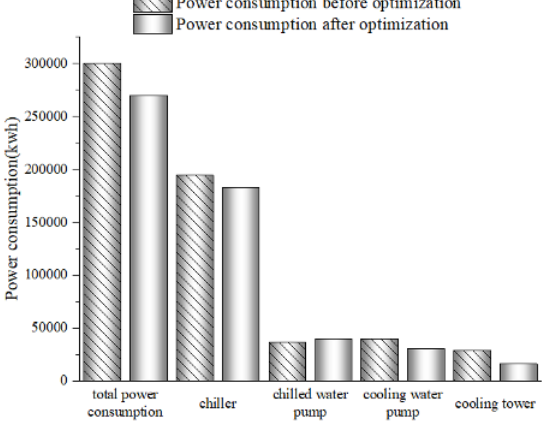
Fig. 6. Comparison of power consumption before and after